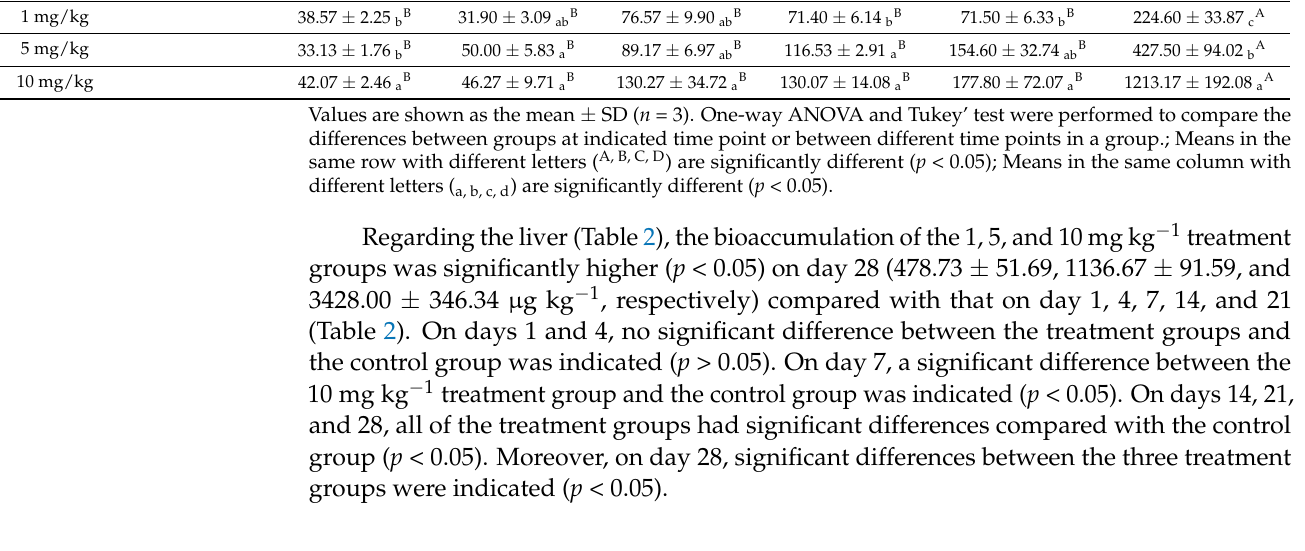
Table 1. Bioaccumulation of methylmercury ( µ g/kg) in muscle tissue of hybrid grouper fed with various concentrations of methylmercury for 28 days. Time Elapsed